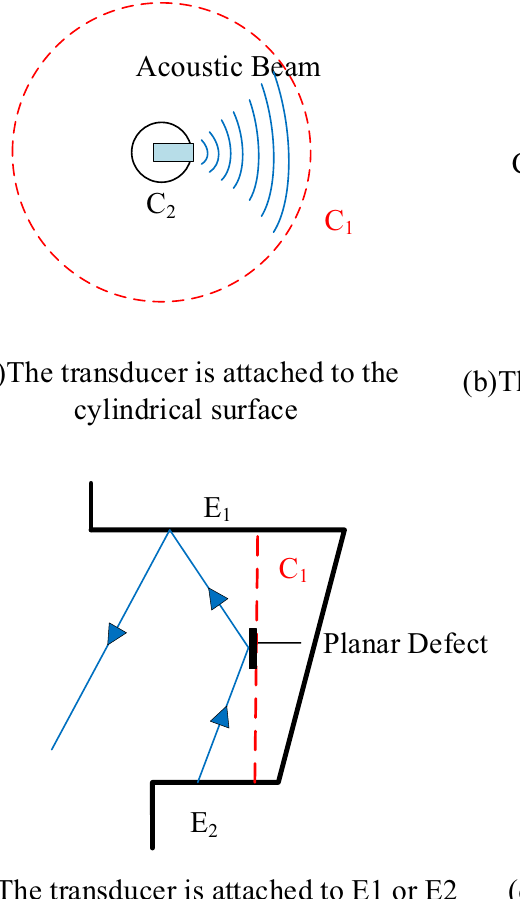
Figure 10. Difficulties in the detection of superalloy turbine